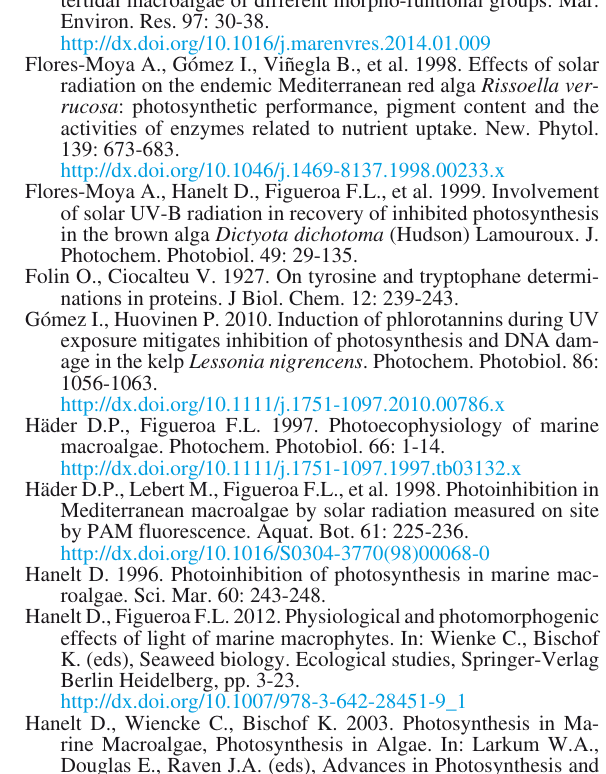
Porphyra leucosticta . Mar. Ecol. Prog. Ser. 151: 81-90. http://dx.doi.org/10.3354/meps151081 Figueroa F.L., Conde-Álvarez R., Gómez I. 2003. Relations be- tween electron transport rates determined by pulse amplitude modulated chlorophyll fluorescence and oxygen evolution in macroalgae under different light conditions. Photosynth. Res. 75: 259-275. http://dx.doi.org/10.1023/A:1023936313544 Figueroa F.L., Martínez B., Israel A., et al. 2009. Acclimation of Red Sea macroalgae to solar radiation: photosynthesis and thal- lus absorptance. Aquat. Biol. 7: 159-172. http://dx.doi.org/10.3354/ab00186 Figueroa F.L., Domínguez-González, B. Korbee N. 2014. Vulner- ability and acclimation to increased UVB radiation in three in- tertidal macroalgae of different morpho-funtional groups. Mar. Environ. Res. 97: 30-38. http://dx.doi.org/10.1016/j.marenvres.2014.01.009 Flores-Moya A., Gómez I., Viñegla B., et al. 1998. Effects of solar radiation on the endemic Mediterranean red alga Rissoella ver­ rucosa : photosynthetic performance, pigment content and the activities of enzymes related to nutrient uptake. New. Phytol. 139: 673-683. http://dx.doi.org/10.1046/j.1469-8137.1998.00233.x Flores-Moya A., Hanelt D., Figueroa F.L., et al. 1999. Involvement of solar UV-B radiation in recovery of inhibited photosynthesis in the brown alga Dictyota dichotoma (Hudson) Lamouroux. J. Photochem. Photobiol. 49: 29-135. Folin O., Ciocalteu V. 1927. On tyrosine and tryptophane determi- nations in proteins. J Biol. Chem. 12: 239-243. Gómez I., Huovinen P. 2010. Induction of phlorotannins during UV exposure mitigates inhibition of photosynthesis and DNA dam- age in the kelp Lessonia nigrencens . Photochem. Photobiol. 86: 1056-1063.